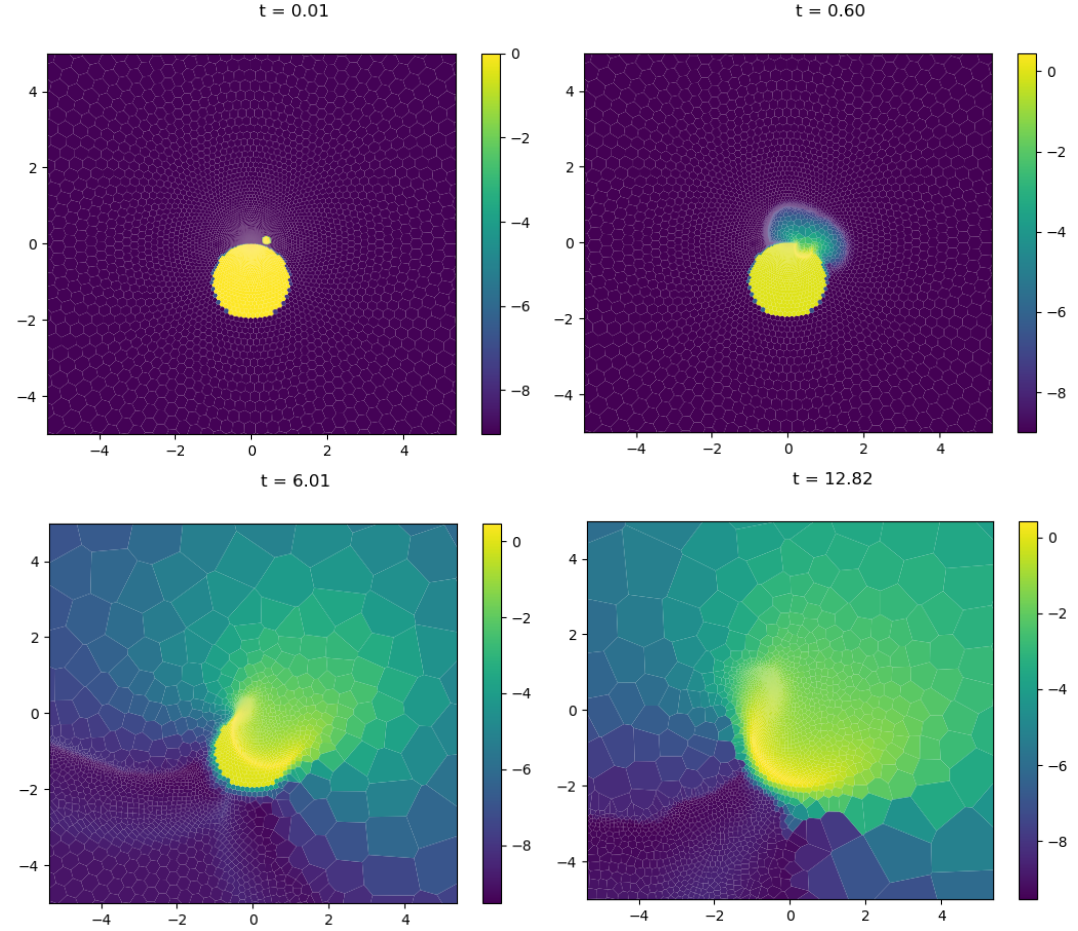
Figure 6. Snapshots from a simulation at different times of a collision between a planet and a planetary core whose radius is a factor of 0.1 smaller. We do not include gravity, thus the planet is obliterated in the end. The simulation is performed using a moving mesh hydrodynamic simulation, thus the polygons are actual computational